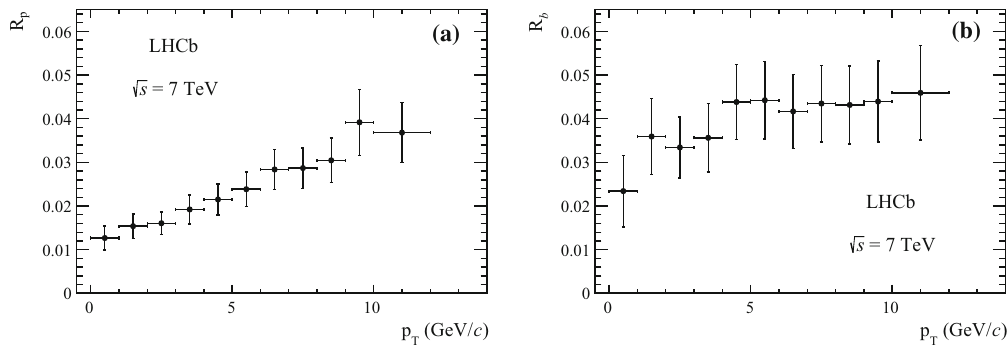
Fig. 9 Ratio of ψ( 2 S ) → μ + μ − and J /ψ → μ + μ − cross-sections for prompt production ( a ) and for b -hadron decay ( b ), as a fucntion of p